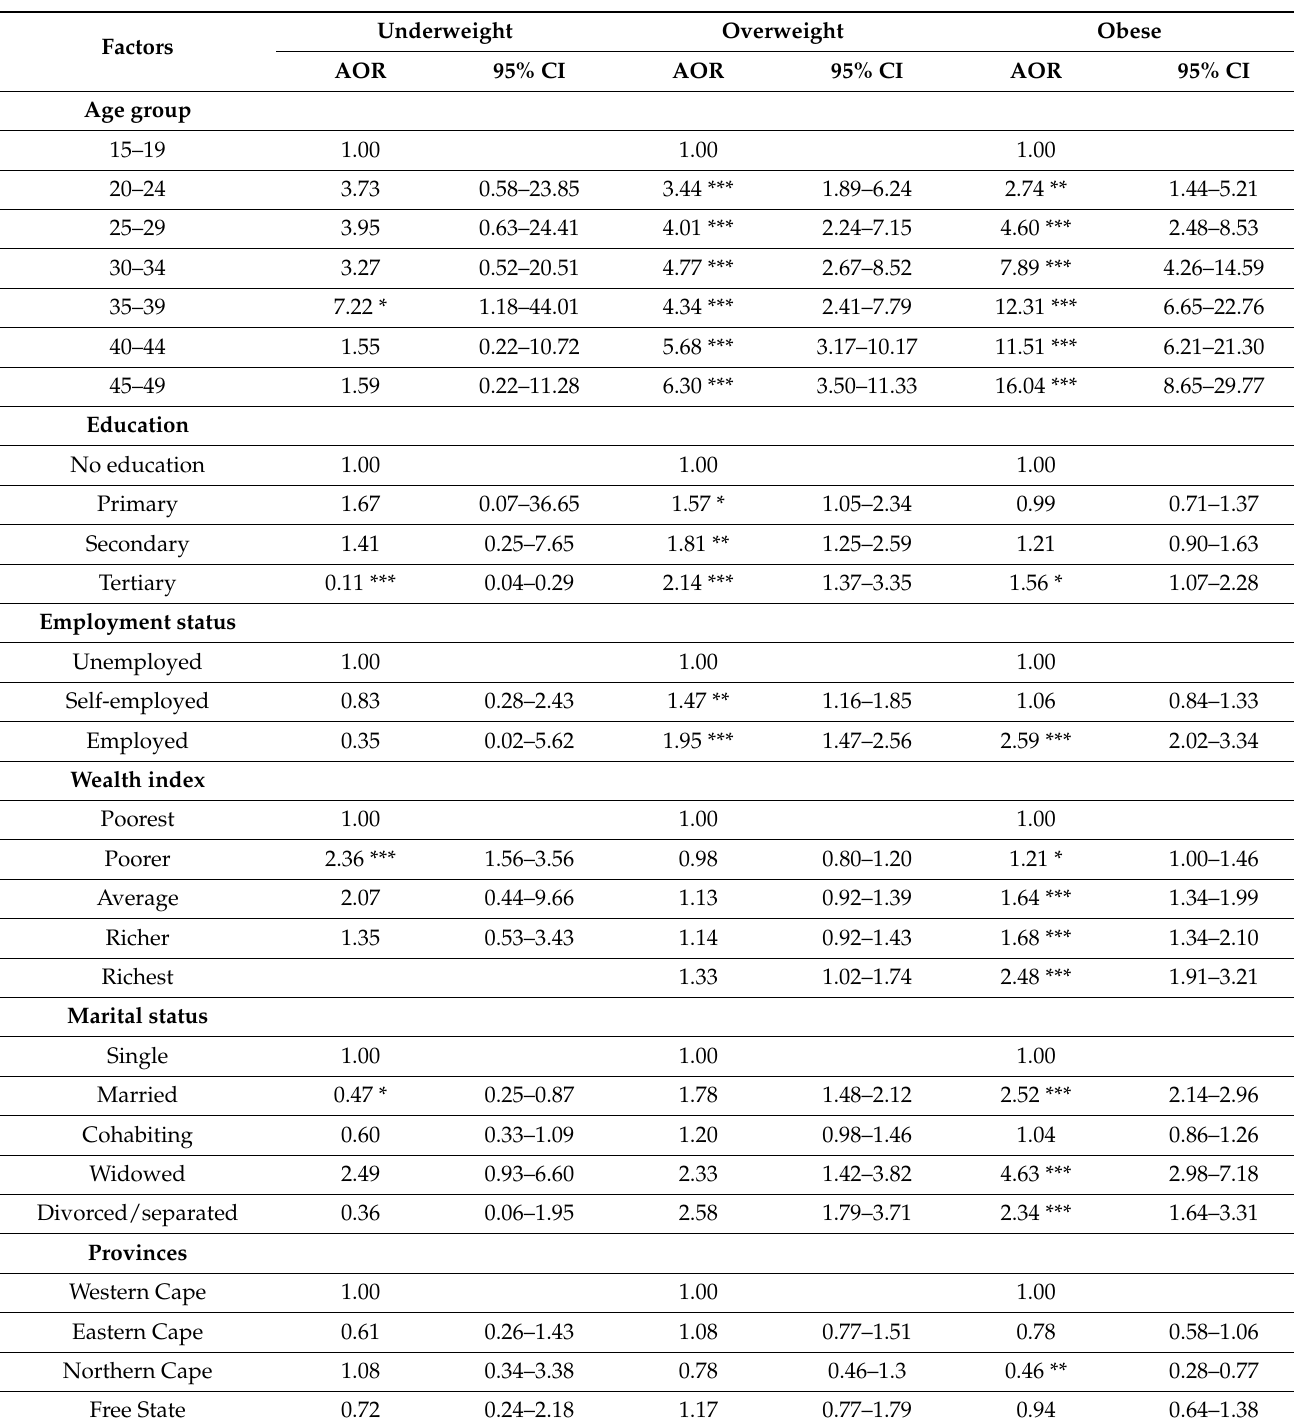
Table 4. Bivariate analysis showing adjusted odds ratio of body weight and its associated factors among women of childbearing age by urban–rural variations in South